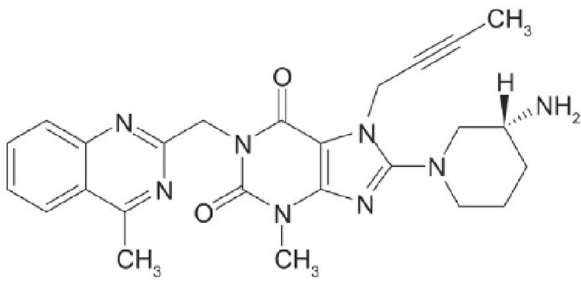
Figure 1. Chemical structure of